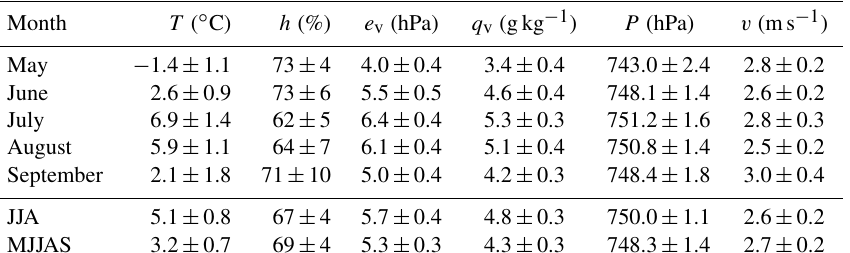
Table 1. Mean monthly weather conditions ± 1SD (standard deviation) at Haig Glacier, Canadian Rocky Mountains, May to Septem- ber 2002–2012. Data are from automatic weather station measurements at an elevation of 2660m, in the upper ablation zone of the glacier.